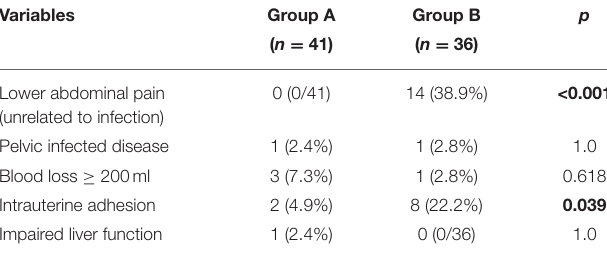
TABLE 3 | Comparison of complications between group A and group B.